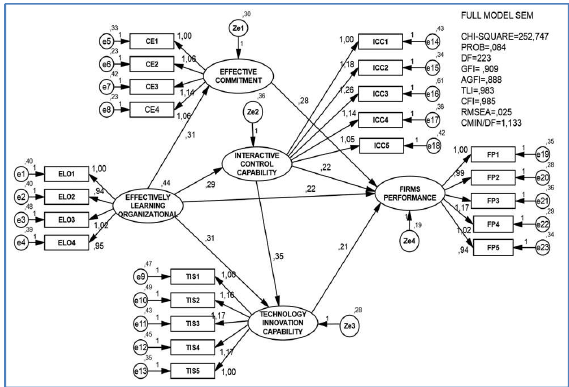
Fig. 1. Full Model SEM Interactive Control Capability (Source: Author’s own work in